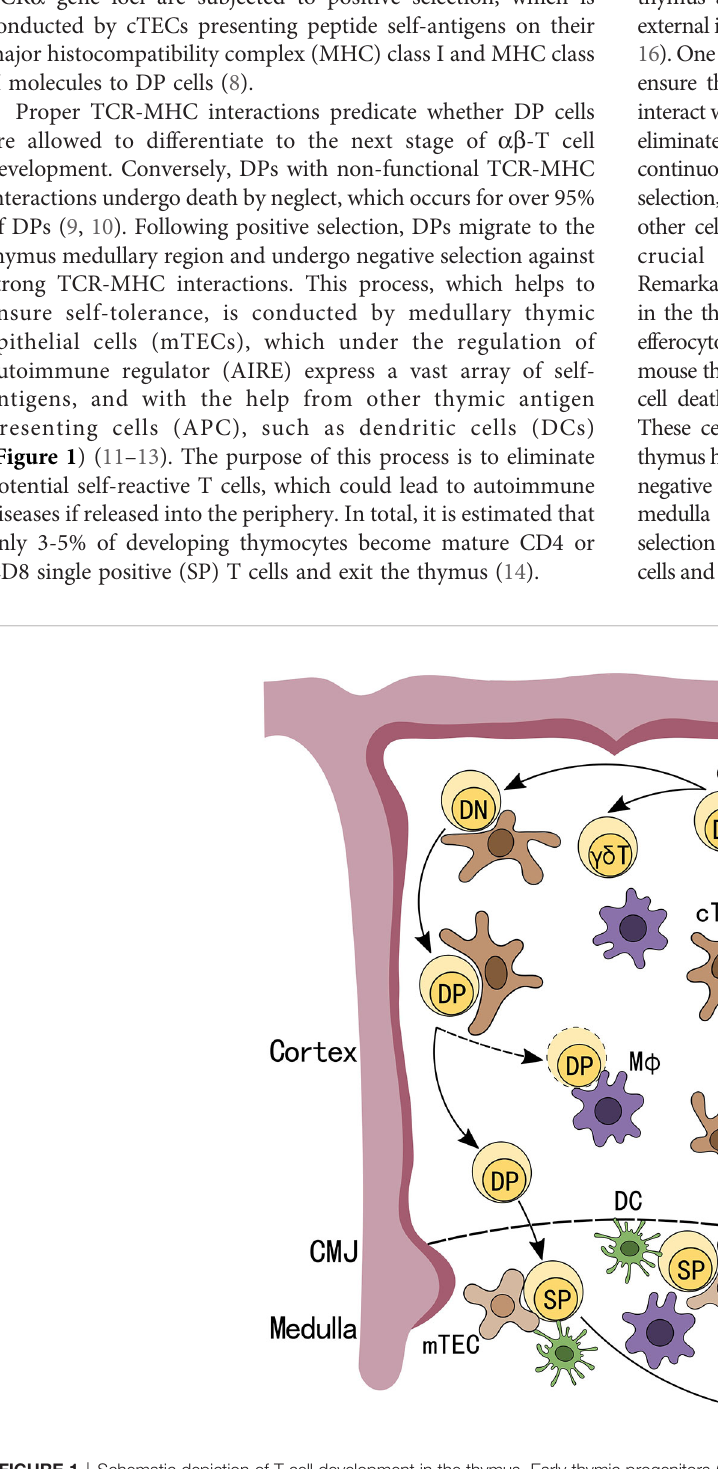
FIGURE 1 | Schematic depiction of T cell development in the thymus. Early thymic progenitors (ETP), arriving from the bone marrow, seed the thymus and receive Notch signals from thymic epithelial cells (TECs) to differentiate into CD4 - CD8 - double negative (DN) T-lineage cells. DN cells that have undergone successful V(D)J rearrangement at TCR b gene loci differentiate into CD4 + CD8 + double positive (DP) cells. After completing TCR a rearrangements and successfully undergoing positive selection, DPs migrate to the thymus medullary region and are subjected to negative selections while DPs that fail positive selection will be programmed for apoptosis. Cells that successfully passed these checkpoints will exit the thymus as CD4 or CD8 single positive (SP) T